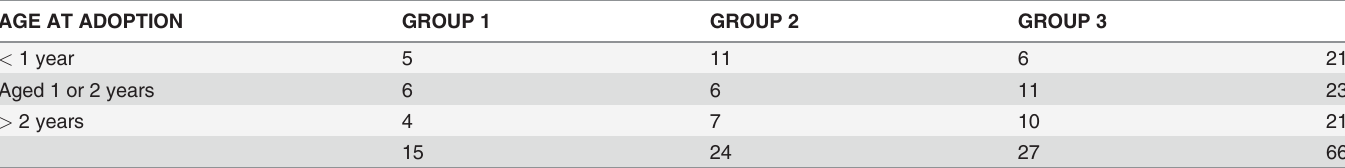
Table 2. Children's age at adoption (according to